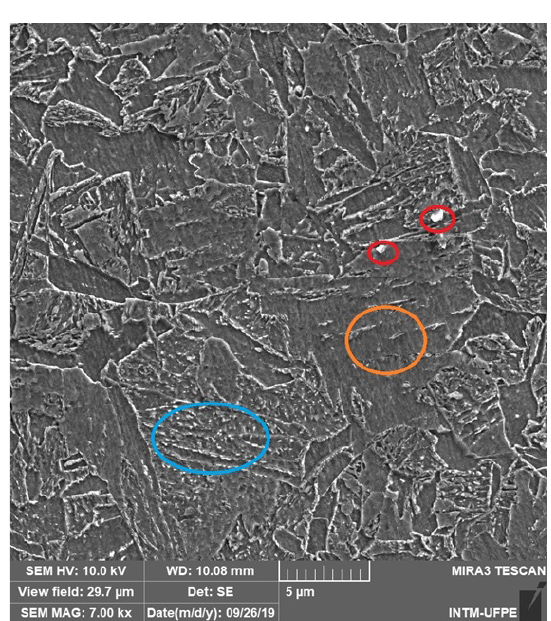
Figure 3. Microstructure of the as received material.